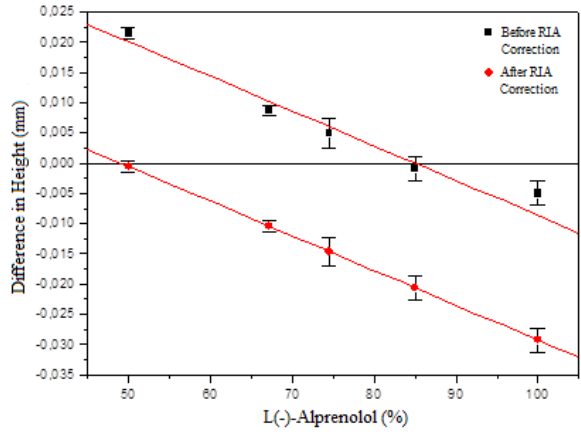
Figure 6: Achiral calibration plots before and after RIA corrections, plotting the difference in polarimetric signal peak height as a function of L(-)-Alprenolol